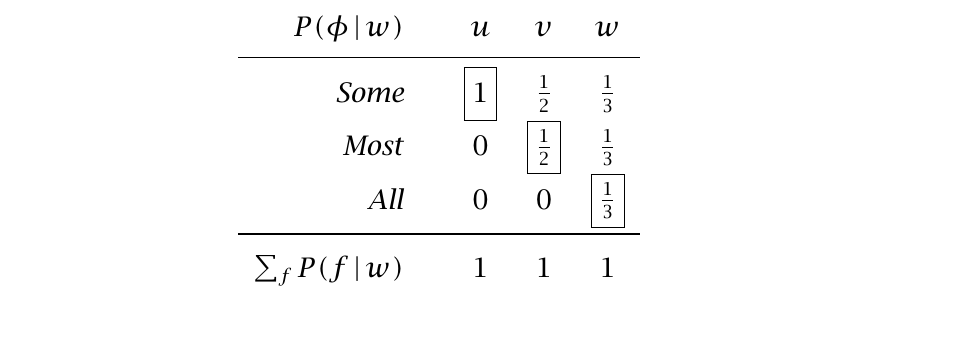
P(φ | w) for standard scale